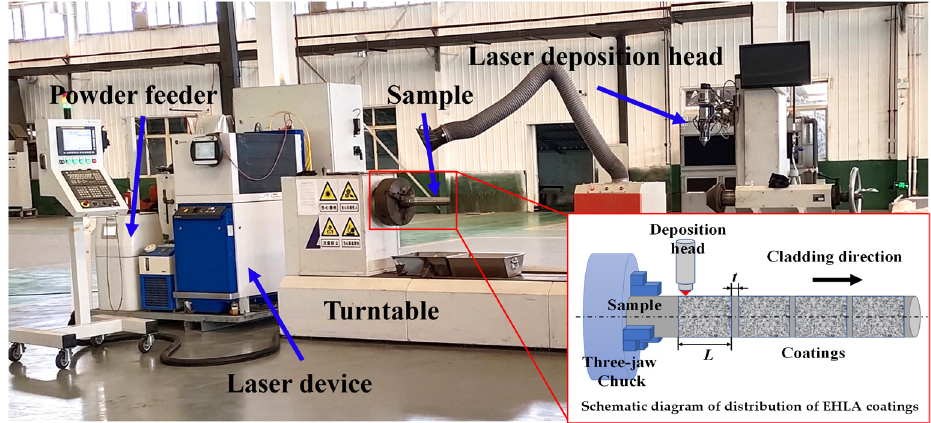
Figure 1. EHLA system.